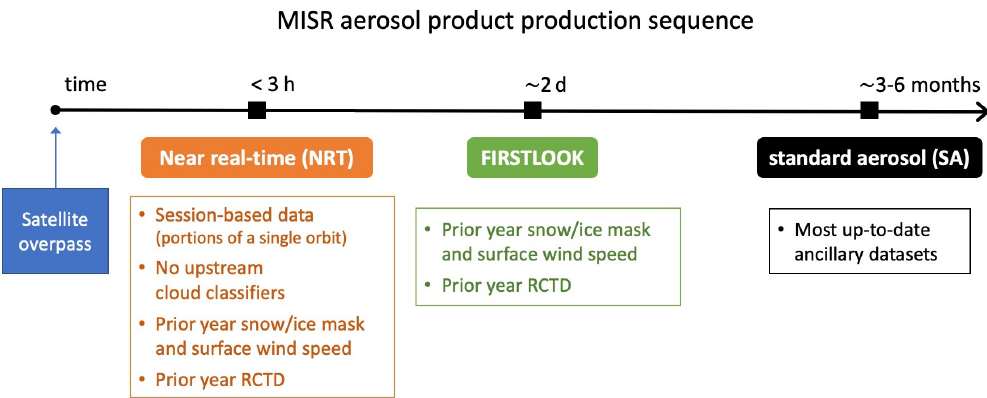
Figure 1. Schematic showing the MISR aerosol product delivery timeline. Snow or ice mask and surface wind speed data are monthly averages. RCTD stands for Radiometric Camera-by-camera Threshold Dataset. MISR final production (SA) is processed on a seasonal cycle and is often delayed 1 to 3 months from the end of each season, which results in a latency of up to 6